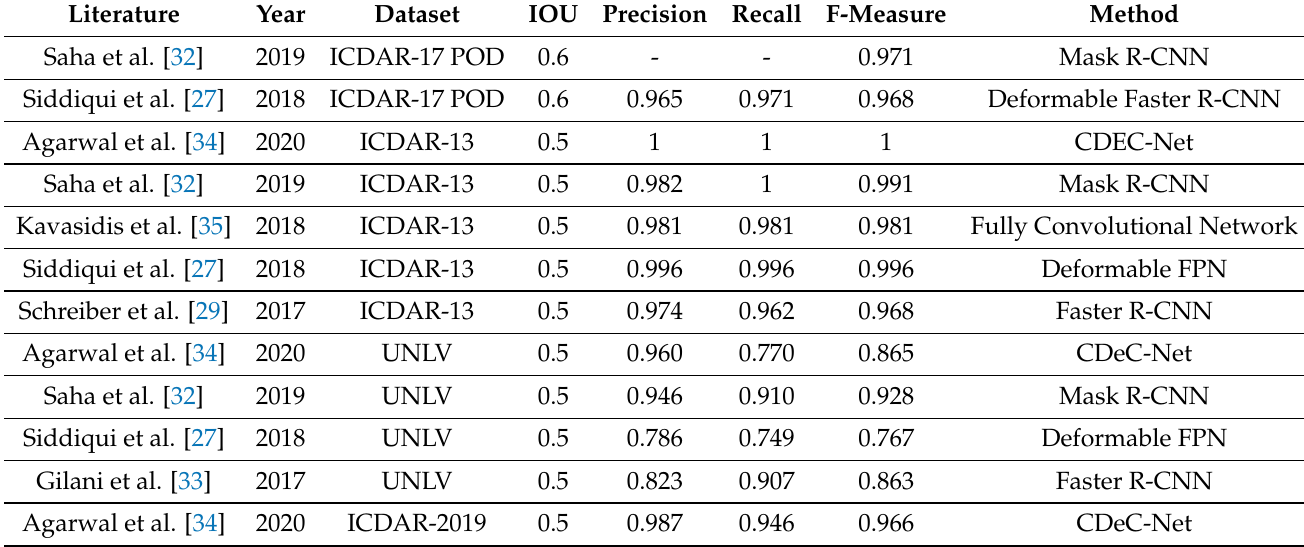
Table 3. Table detection performance evaluation across various datasets. The double horizontal line divides the em- ployed